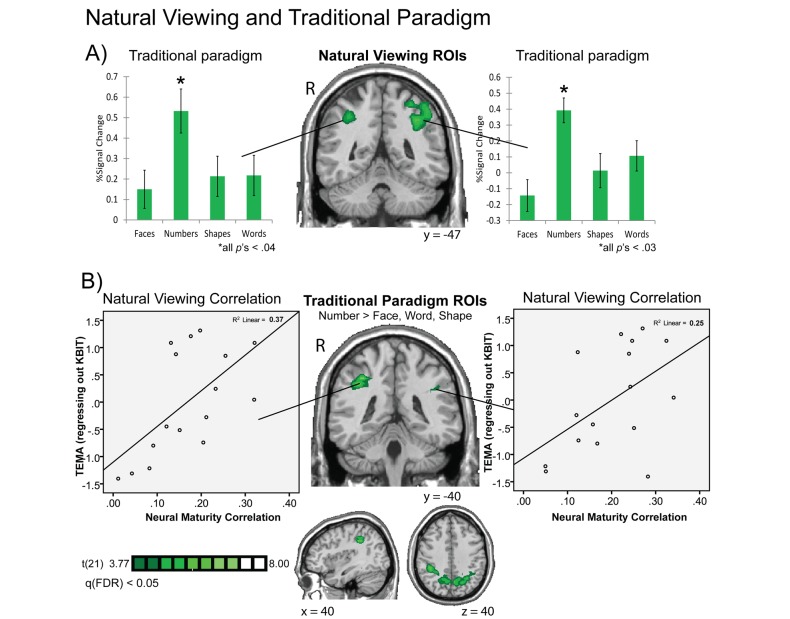
Cross-comparison of natural viewing and traditional task results.(A) IPS regions that exhibited a correlation between children's natural viewing neural maturity and math IQ test score also exhibited a selective response to numerical stimuli compared to face, shape, and word stimuli in a traditional fMRI paradigm. (B) And vice versa, IPS regions that exhibited a significantly greater response to the numerical stimuli in a traditional fMRI paradigm in children (numbers > faces + words + shapes, FDR corrected, p<0.05) also exhibited a significant correlation between children's neural maturity from the natural viewing paradigm and their mathematics test scores (TEMA-3).